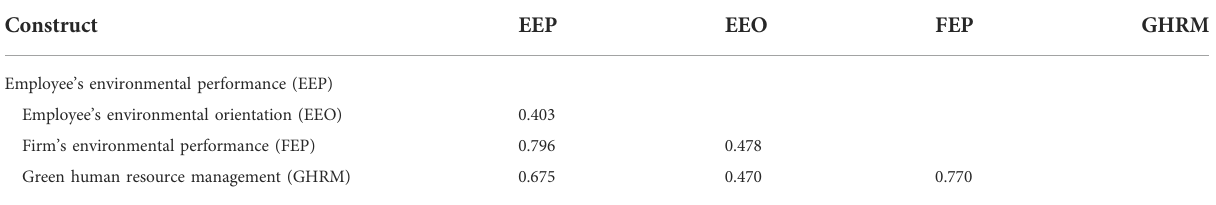
TABLE 3 Discriminant validity using heterotrait – monotrait